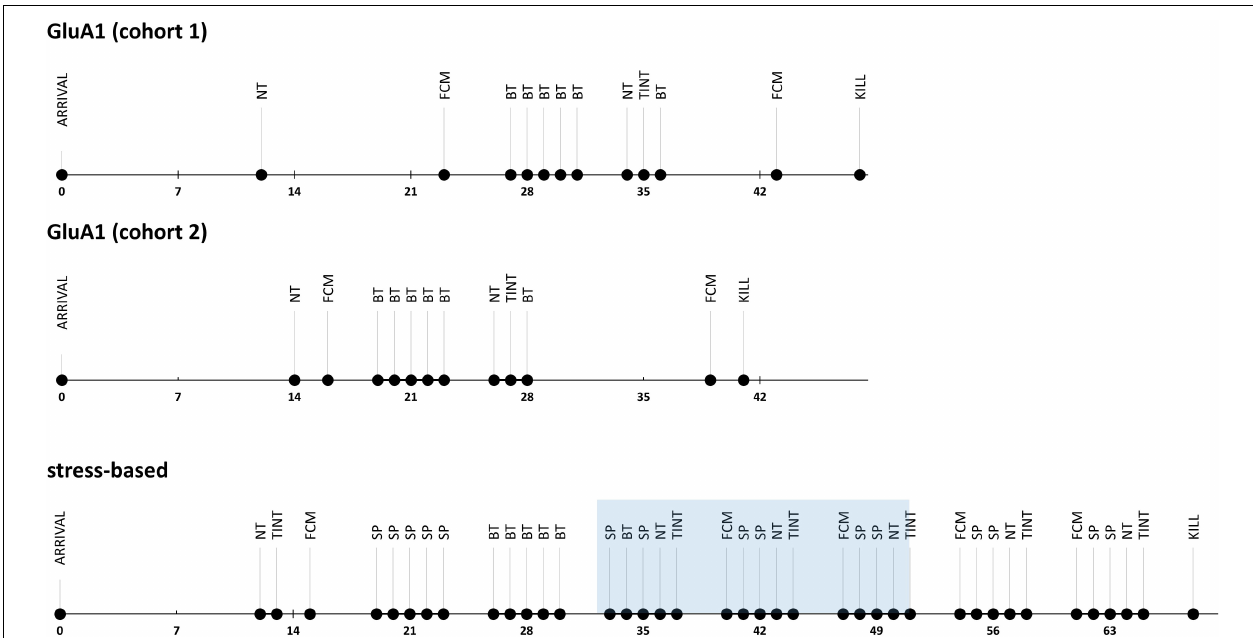
FIGURE 1 | Experimental design: time lines of the severity assessment experiments. NT, nest test; FCM, fecal corticosterone metabolite sampling; BT, burrowing test; TINT, time to integrate into nest test, SP, saccharin